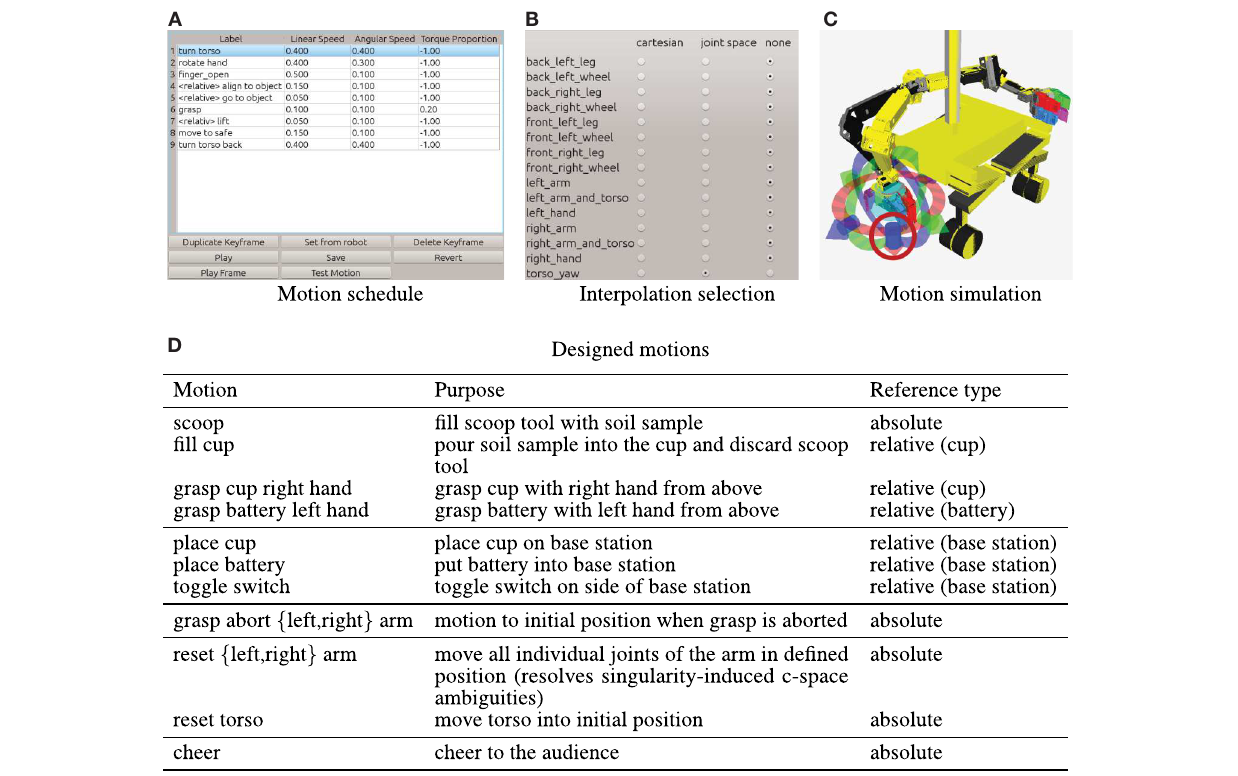
FIGURE 8 | Keyframe editor GUI . (A) Motions are designed step by step and can be absolute or relative to perceived objects. (B) The user can select which joint groups are included in the currently edited keyframe and if interpolation between keyframes is Cartesian or joint space. (C) The real position of the robot is indicated in black. The currently edited keyframe target is shown in yellow. Interactive markers can be used to modify the keyframe pose in 6D (here only for the right hand). A model of the cup (blue, circled red) is placed in front of the robot to assist designing relative motions. (D) Overview of the custom motions designed for the SpaceBot Camp